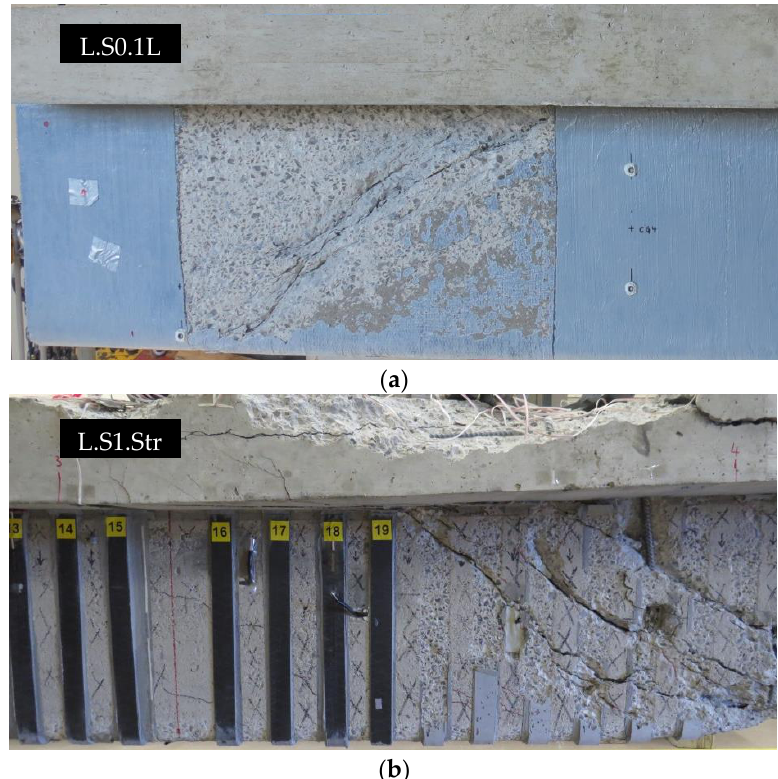
Figure 4. Cracks pattern: ( a ) specimens without stirrups L.S0.1L and ( b ) specimens with stirrups L.S1.Str.